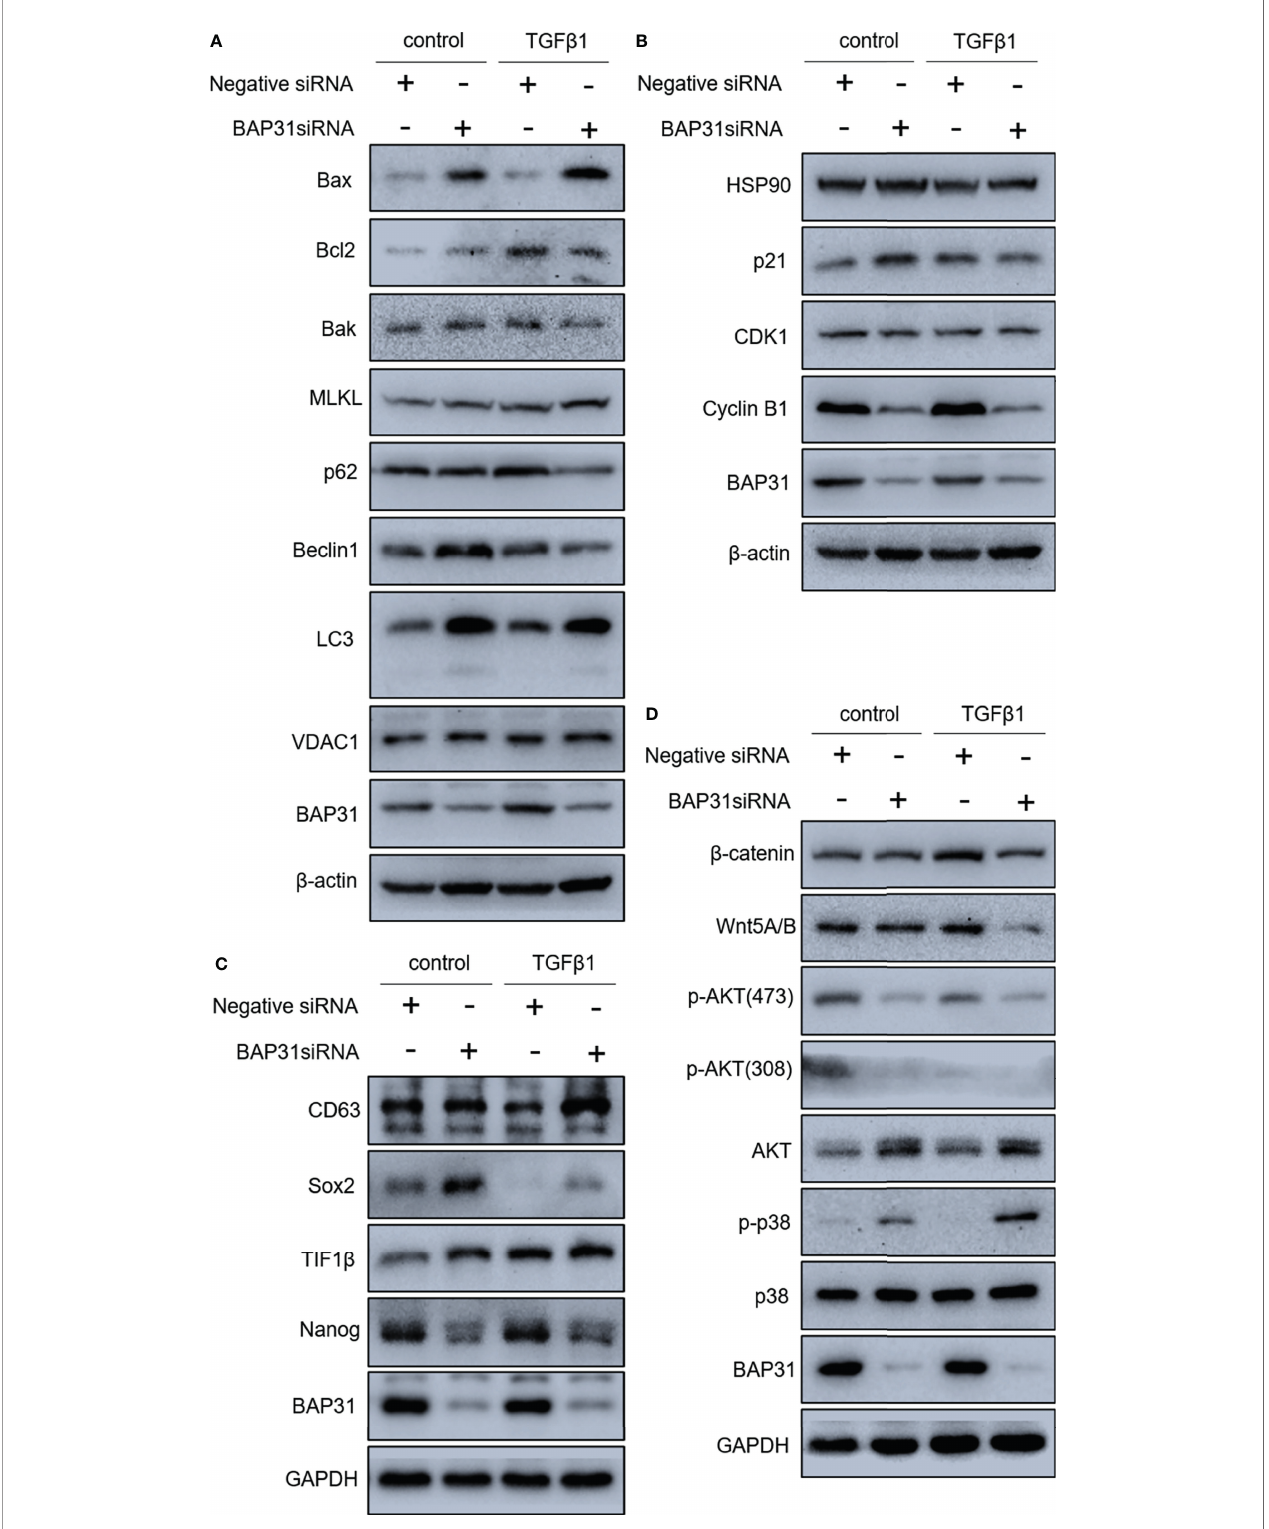
FIGURE 7 | Gene expression in A549 lung cancer cells received combinatorial treatment with TGF b and BAP31 siRNA via Western blot. (A) Expression of cell death-related genes. (B) Gene expression related to cell cycle distribution. (C) Expression of genes associated with stemness. (D) Determination of gene expression in signaling